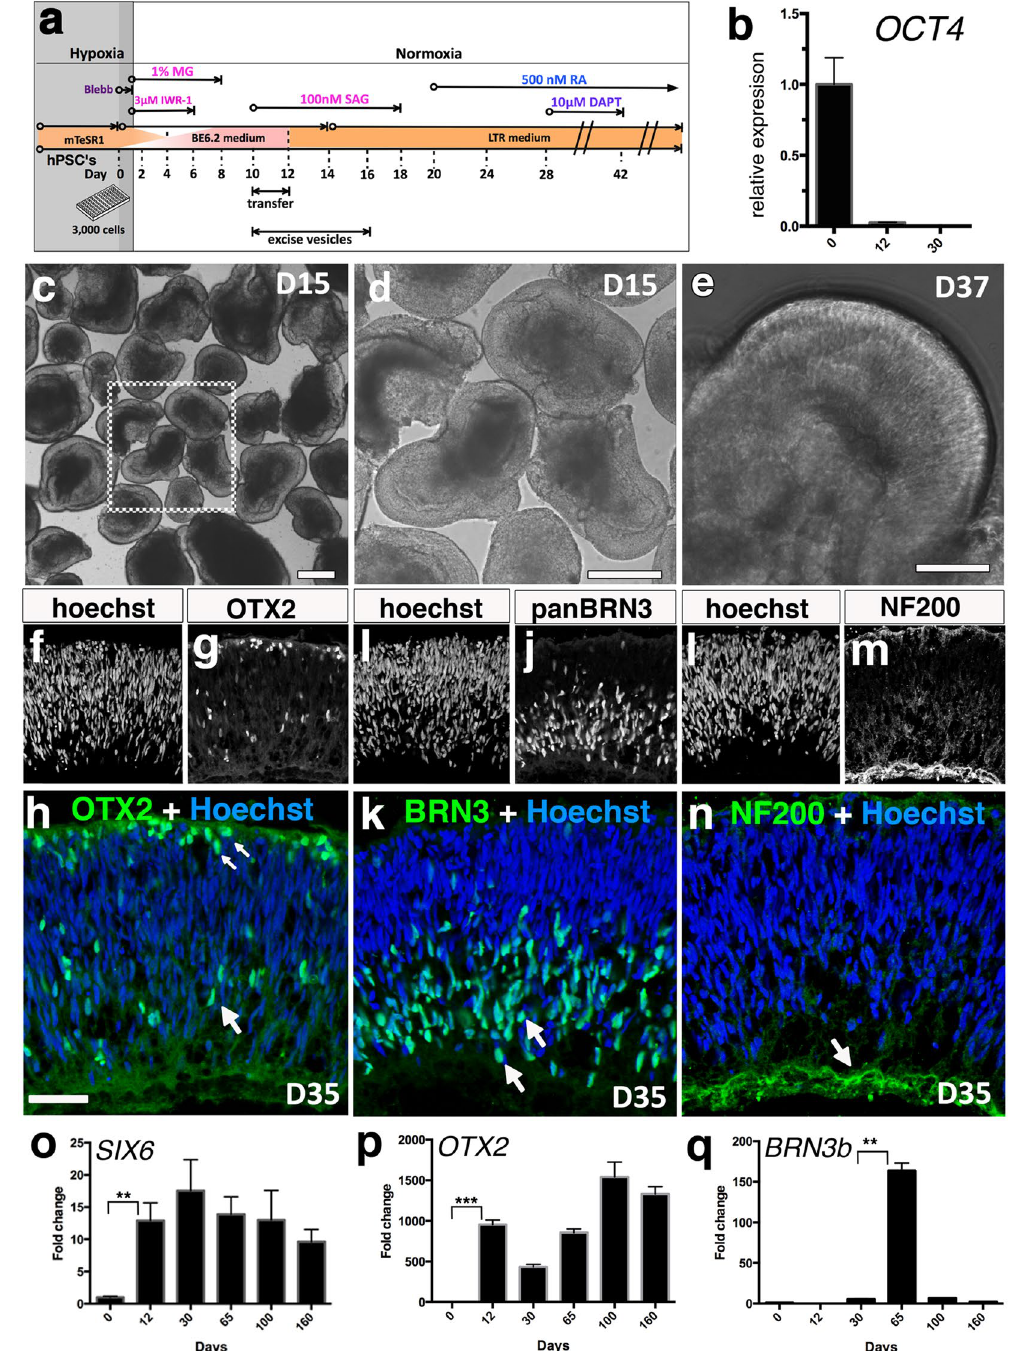
Figure 2. Bulk isolation of optic vesicle-like structures and early characterization in IMR90.4 iPSCs. ( a ) The treatment leading to optic vesicles and retina cups. ( b ) Quantitative PCR analysis of OCT4. ( c ) Cup shaped vesicles at D15 are separated from non-cup shaped vesicles. ( d ) Viewed at higher magnification, is a 3D retinal cup. ( e ) At D37 RC’s maintain their cup-like morphology. ( f – h ) Tissue sections from vesicles probed with antibodies against OTX2 at D35 label retinal progenitors and possibly PRs. ( i – k ) BRN3 + cells mark RGC’s in the inner retina. ( l – n ) NF200 labels the entire retina with enhanced labeling of RGC axon bundles. ( f , i , l ) Hoechst was used as a nuclear counterstain. ( o , p , q ) Quantitative PCR analysis of the early retinal markers SIX6, OTX2, and BRN3 was performed on cDNA samples pooled (n = 10) from differentiated IMR90.4 iPSCs to confirm their expression. Data from pooled samples (n = 10 per time point) was calculated using three replicates per time point and error bars represent s.e.m. The difference between the indicated time points is statistically significant by Student’s t-test where *** P < 0.001, ** P < 0.01, ns, not significant. PR = photoreceptor; RC = retina cup; RGC = retinal ganglion cell. Scale bars ( a , b ) = 500 μ m; ( c ) = 200 μ m; ( d ) = 100 μ